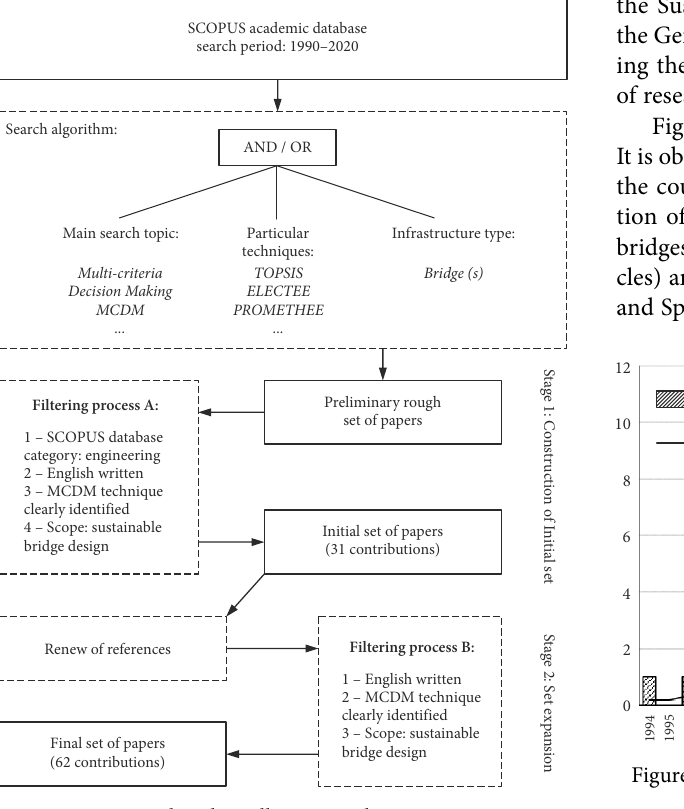
Figure 1. Flowchart illustrating the systematic